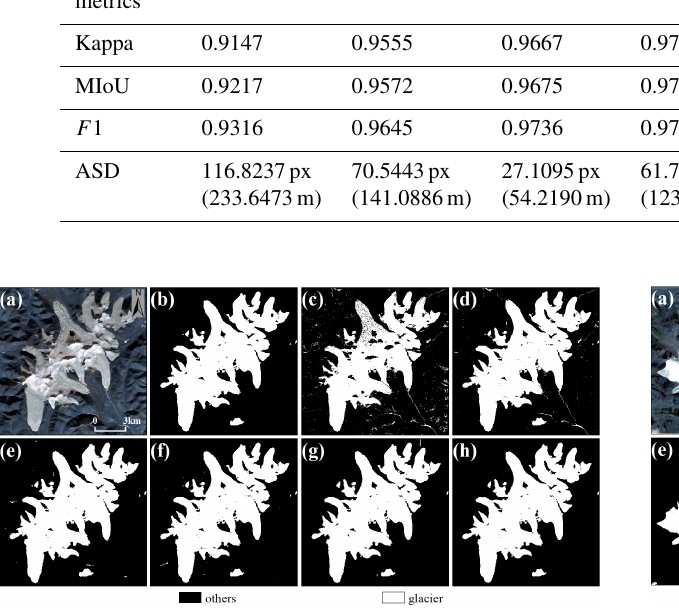
Figure 12. Demonstration of glacier extraction based on the image of 20 December 2020 (regional centroid coordinates of 33.40 ◦ N, 91.54 ◦ E). (a) The RGB image, (b) the ground truth, and (c) – (h) SBTM, RF, FCN, U-Net, DeepLab V3 + and Attention DeepLab V3 + with TTA, respectively.